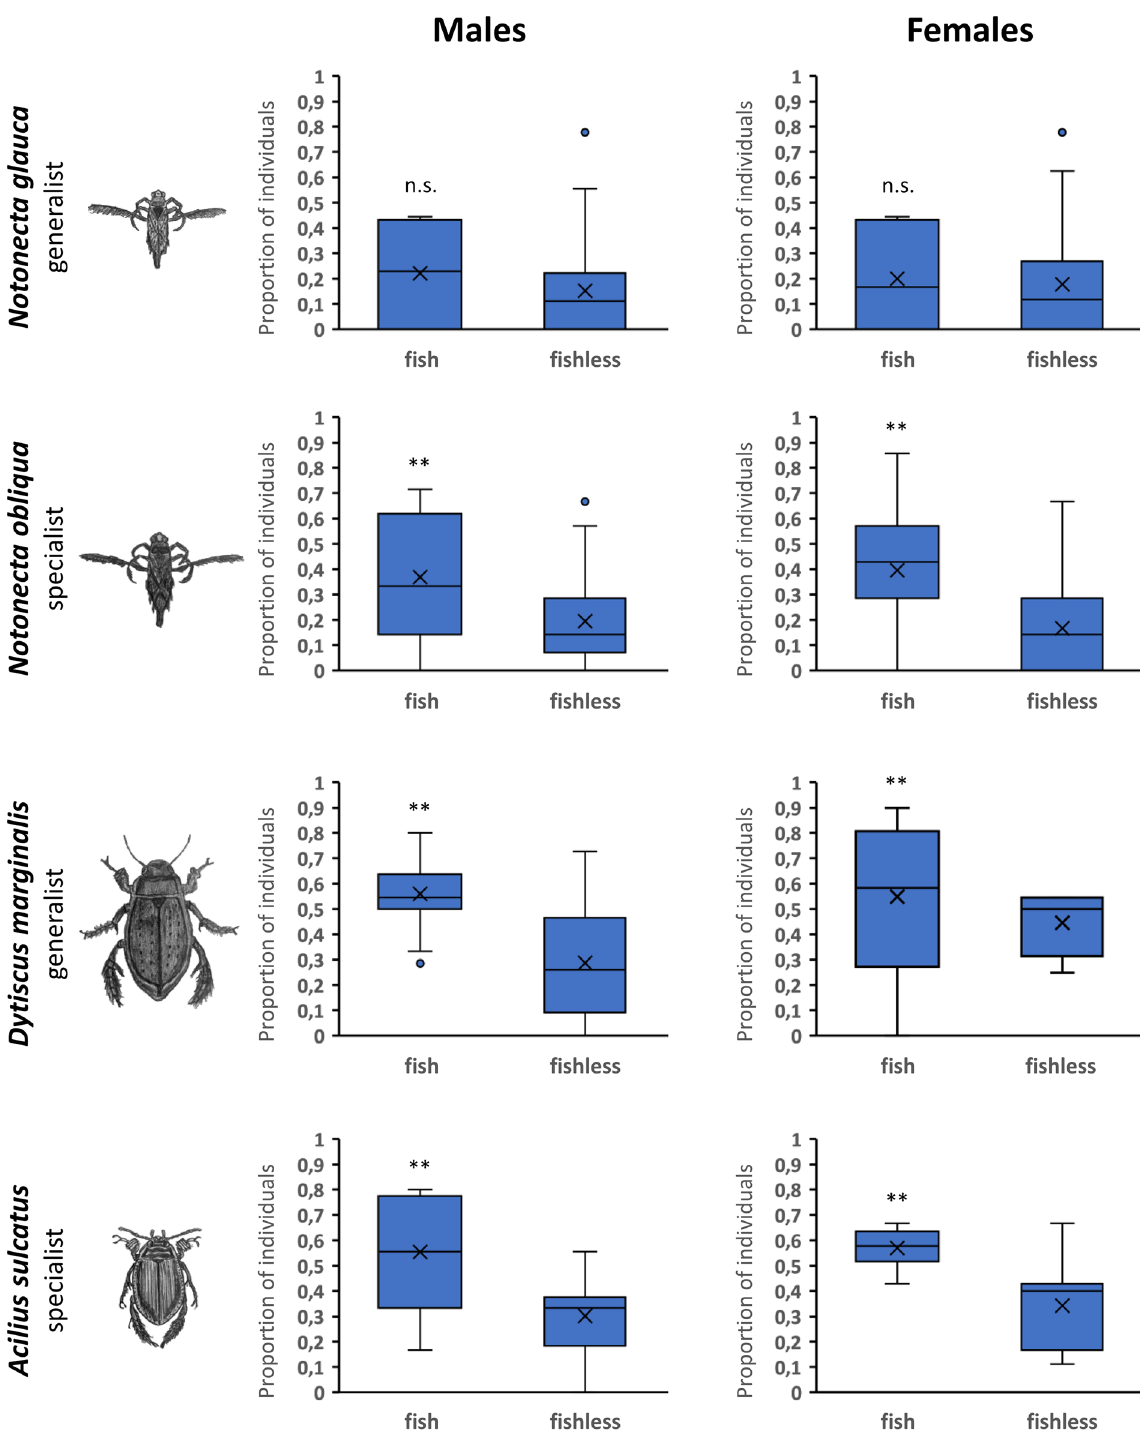
Figure 3. Habitat change frequency in relation to the initial choice. The proportion of individuals who switched the habitat type (from fish-containing to fishless and vice versa) after the first sampling